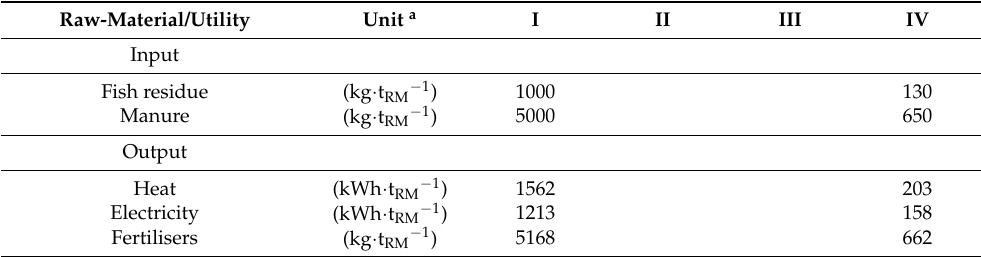
Table 2. Material and energy balance of the biogas plant.